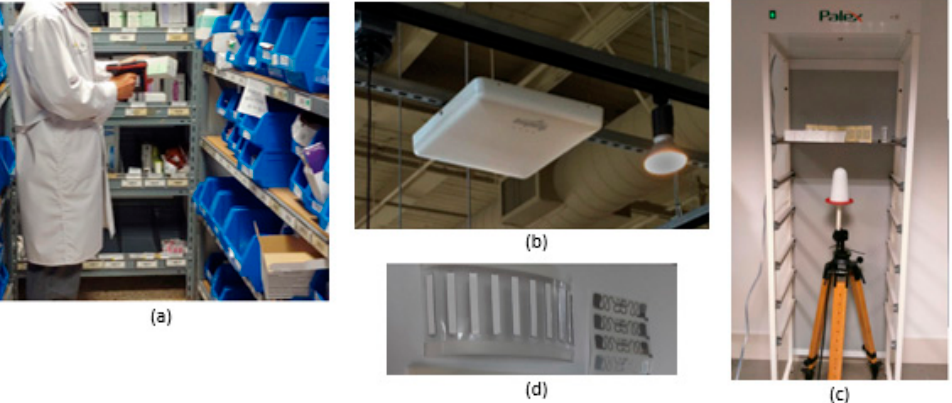
Figure 2. The RFID UHF readers used for the purpose of the study and commonly used at hospitals: ( a ) handheld reader AB700 (reader type: MO-RFID); ( b ) fixed xArray Gateway R680 (reader type: AG-RFID); ( c ) shelving DYANE Smartshelf (reader type: AS-RFID), ( d ) passive RFID tags compliant with ( a – c ) readers (type: EPCglobal UHF RFID Class 1 Gen 2). Table 1. The Specifications of RFID UHF readers commonly used at hospitals and used during the study.